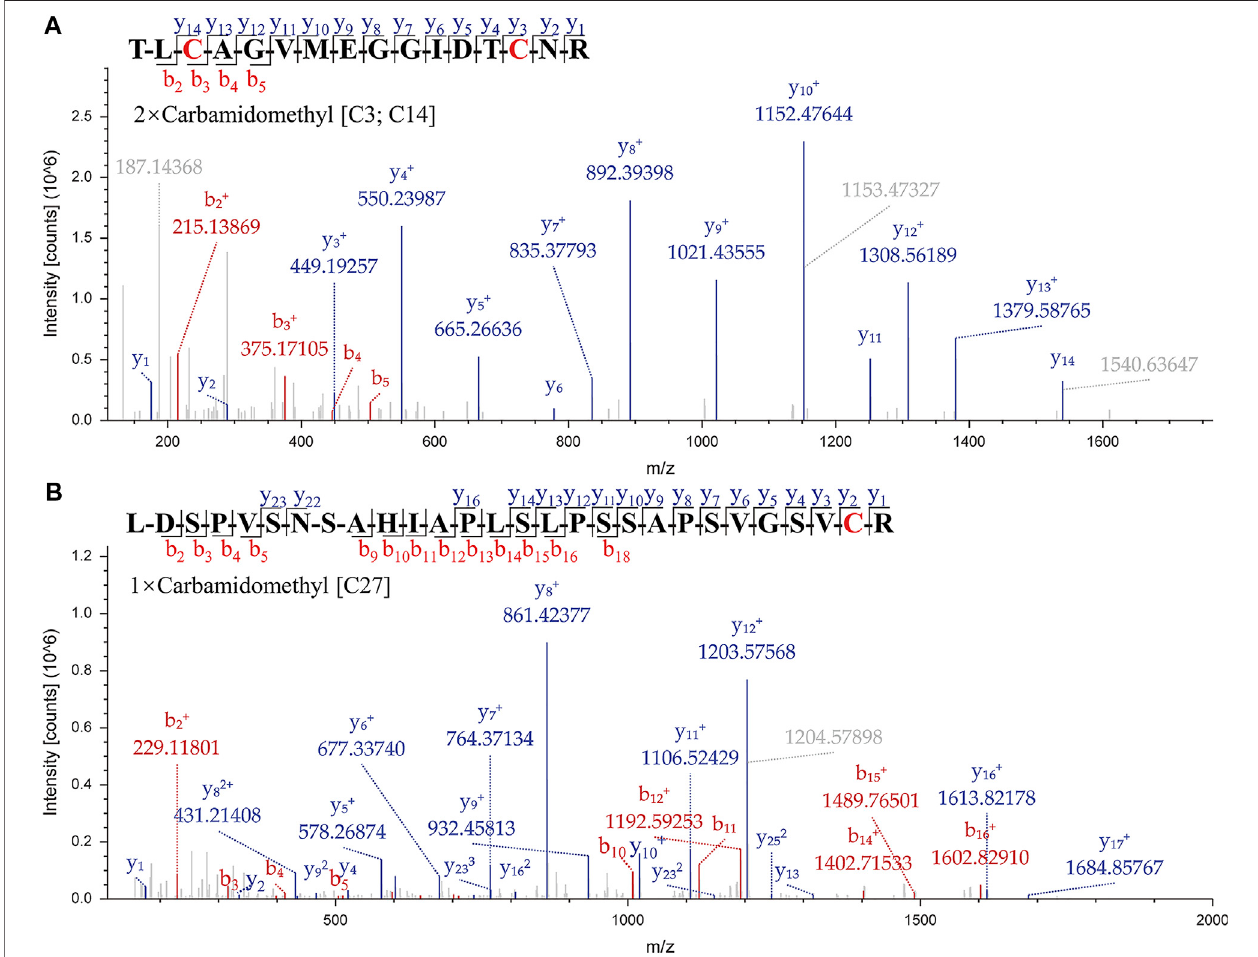
FIGURE 3 | MS/MS spectrums of the marker peptides for Agkistrodon halys pallas . (A) Peptide TLCAGVMEGGIDTCNR, m/z = 877.39, double charged. (B) Peptide LDSPVSNSAHIAPLSLPSSAPSVGSVCR, m/z = 935.81, triple charged.